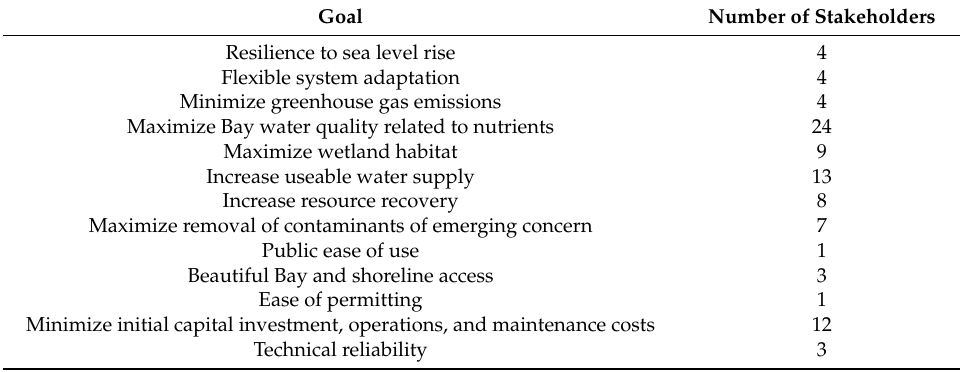
Table 1. Number of stakeholders who mentioned each goal for “good nutrient management” in initial interviews (of 32 total).